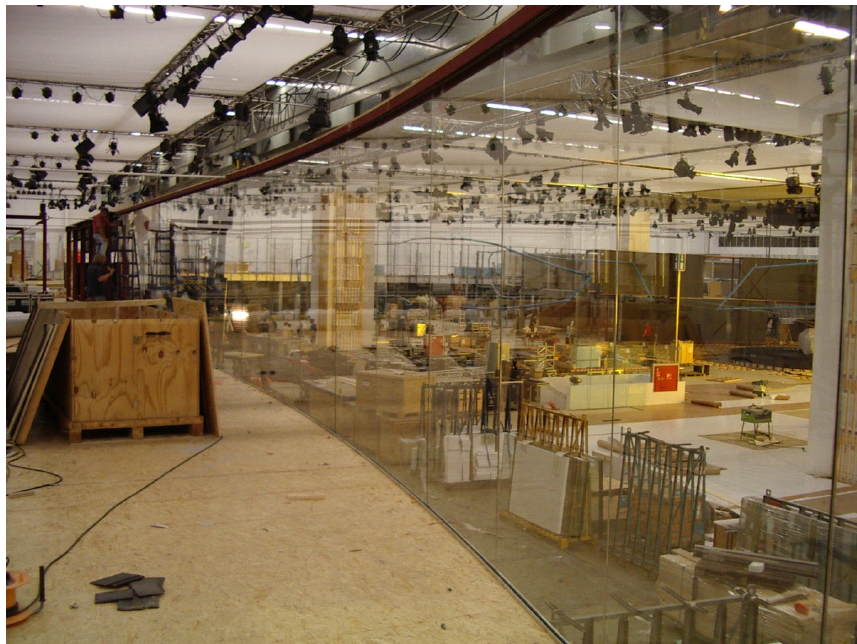
Figure 9: Plane panes at the longitudinal